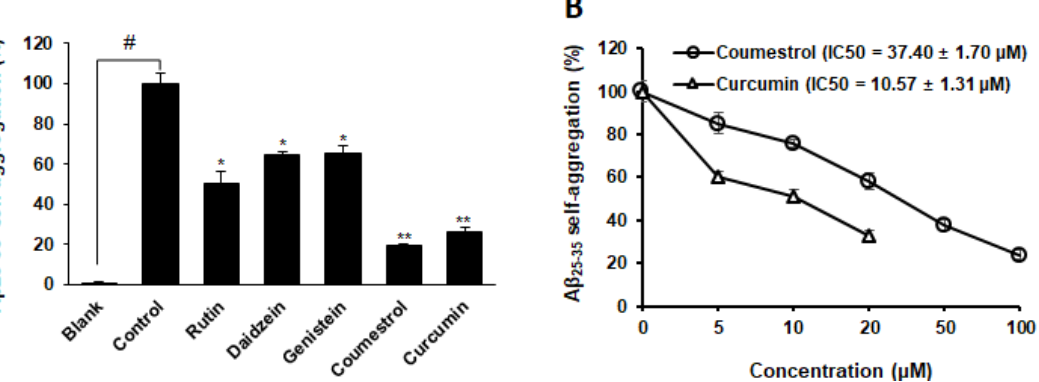
Figure 3. Extent of A β 25–35 self-aggregation in the presence and absence of phytoestrogens (100 µM) along with positive control (20 µM curcumin) based on a quantitative thioflavin-T binding assay ( A ). Data are shown as mean ± SD ( n = 3). # p < 0.0001 denotes a substantial difference from the non-aggregated group (blank). * p < 0.001 and ** p < 0.0001 denote substantial differences from the aggregated A β 25-35 (100 µM) group (control). Dose-dependent inhibition of A β 25–35 self-aggregation by coumestrol ( B ).